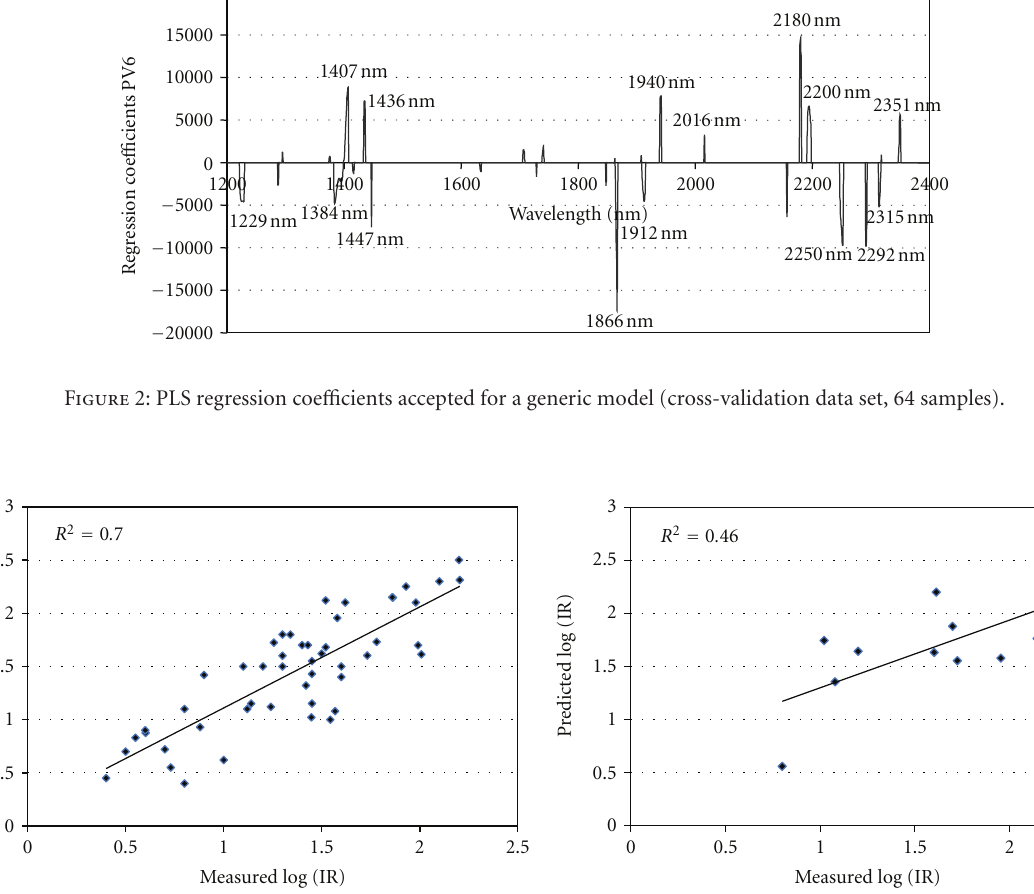
Figure 3: (a) Measured versus predicted values of logarithmically transformed infiltration rates (IR). Results of cross-validation modeling run on the calibration set (53 samples, second derivative of absorbance run on 48 wavelengths). (b) 10 measured versus predicted IRs of the external test set ( N = 11